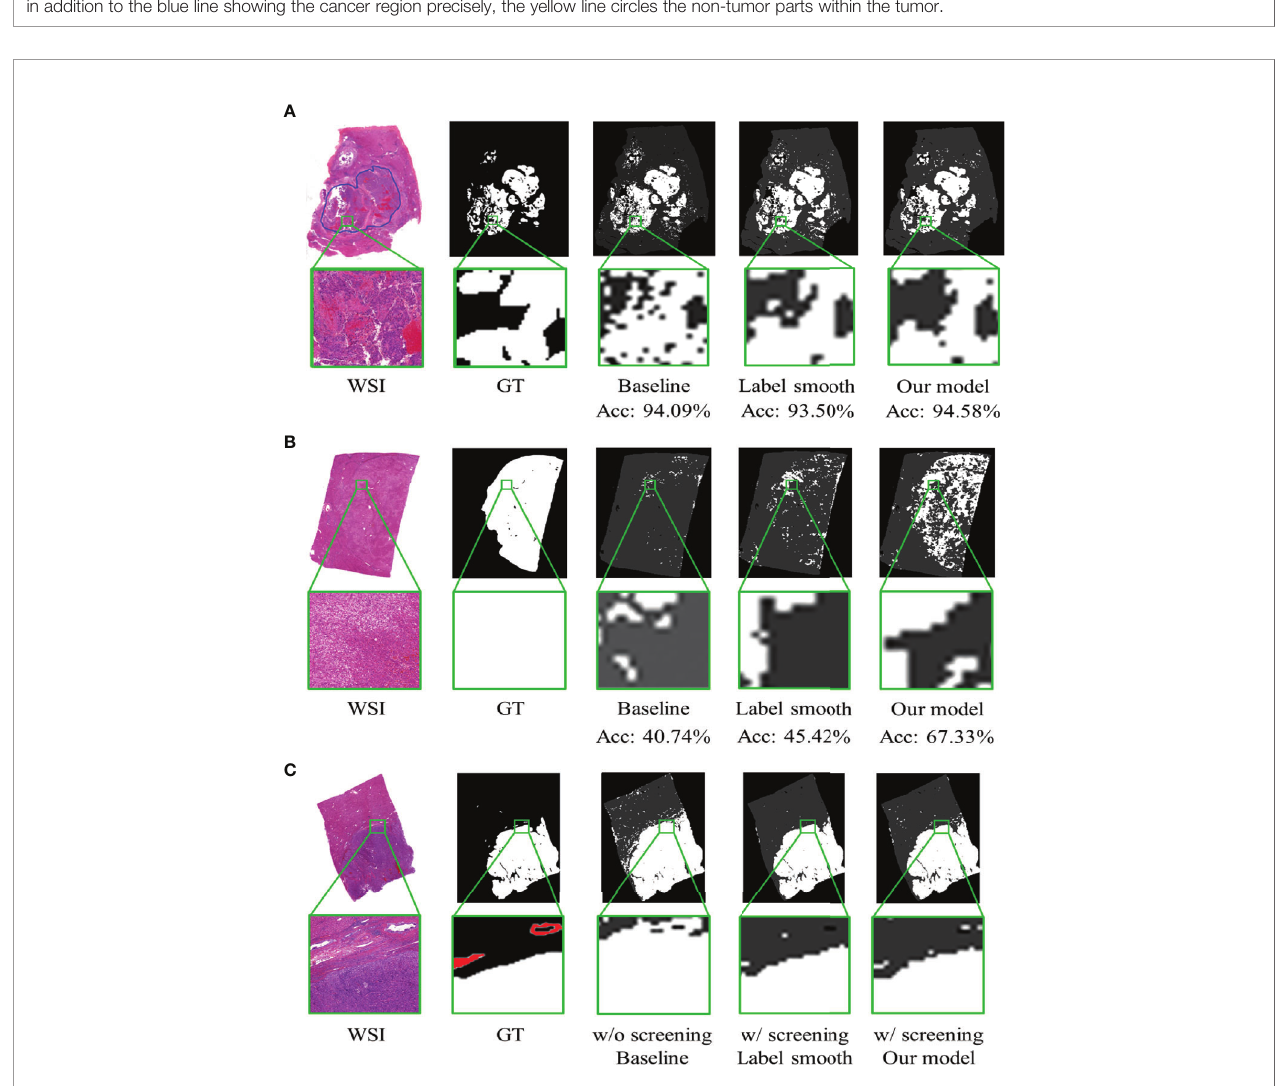
FIGURE 5 | The visualization of model prediction on whole-slide images. Acc denotes the overall accuracy of the slide. (A) Differentiation of the proposed model in the suspected area of tumor. (B) Recognition of the proposed model in well-differentiated hepatocellular carcinoma. (C) Recognition of the proposed model in microvascular invasion (MVI). The white region denotes the tumor, and the red regions denote the